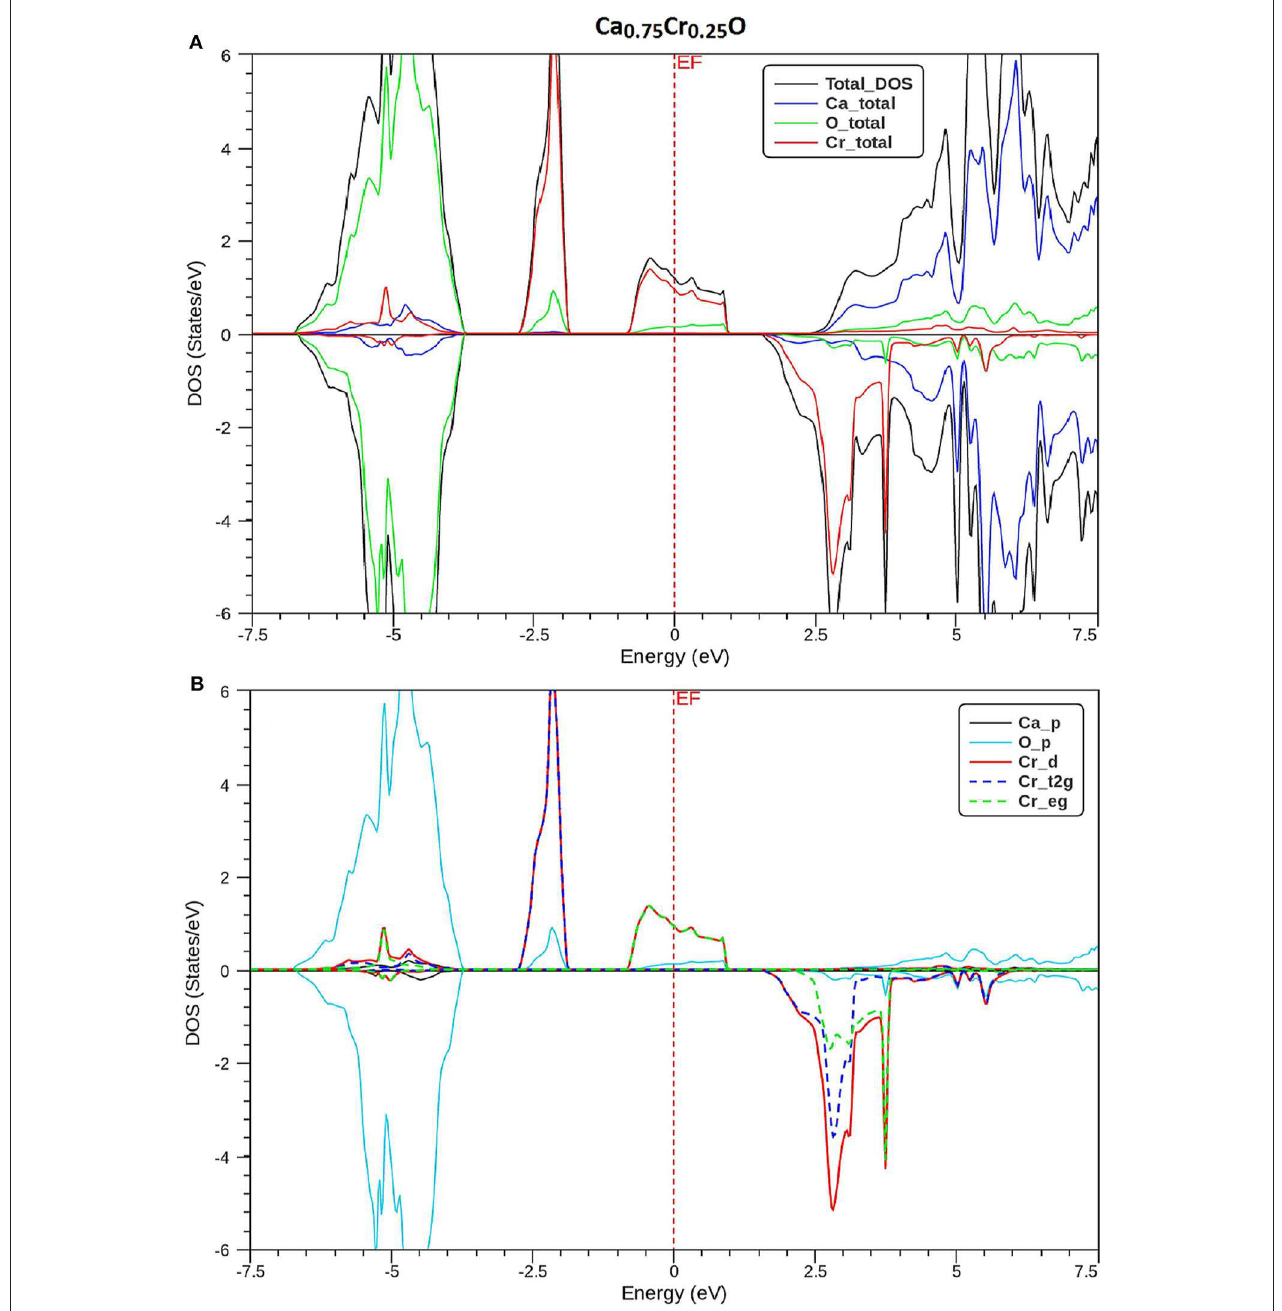
FIGURE 8 | Spin-polarized total and partial densities of states (DOS) of Ca 0.75 Cr 0.25 O. The Fermi level is set to zero ( vertical dotted line ). (A) Total DOS of Ca, Cr, and O and (B) Partial DOS of p-Ca, p-O, d-Cr, t2g_d-Cr, and